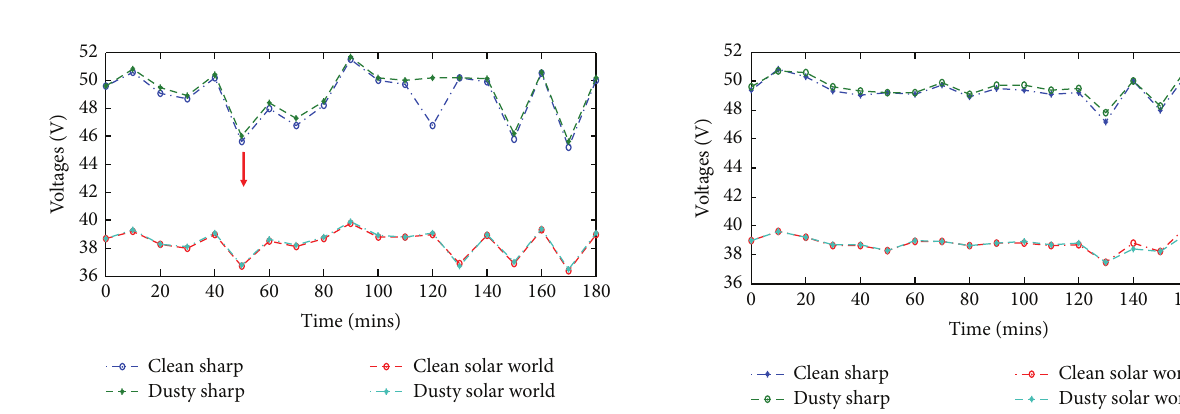
Figure 8: Voltage-time on day four (12:00–15:00 daily).